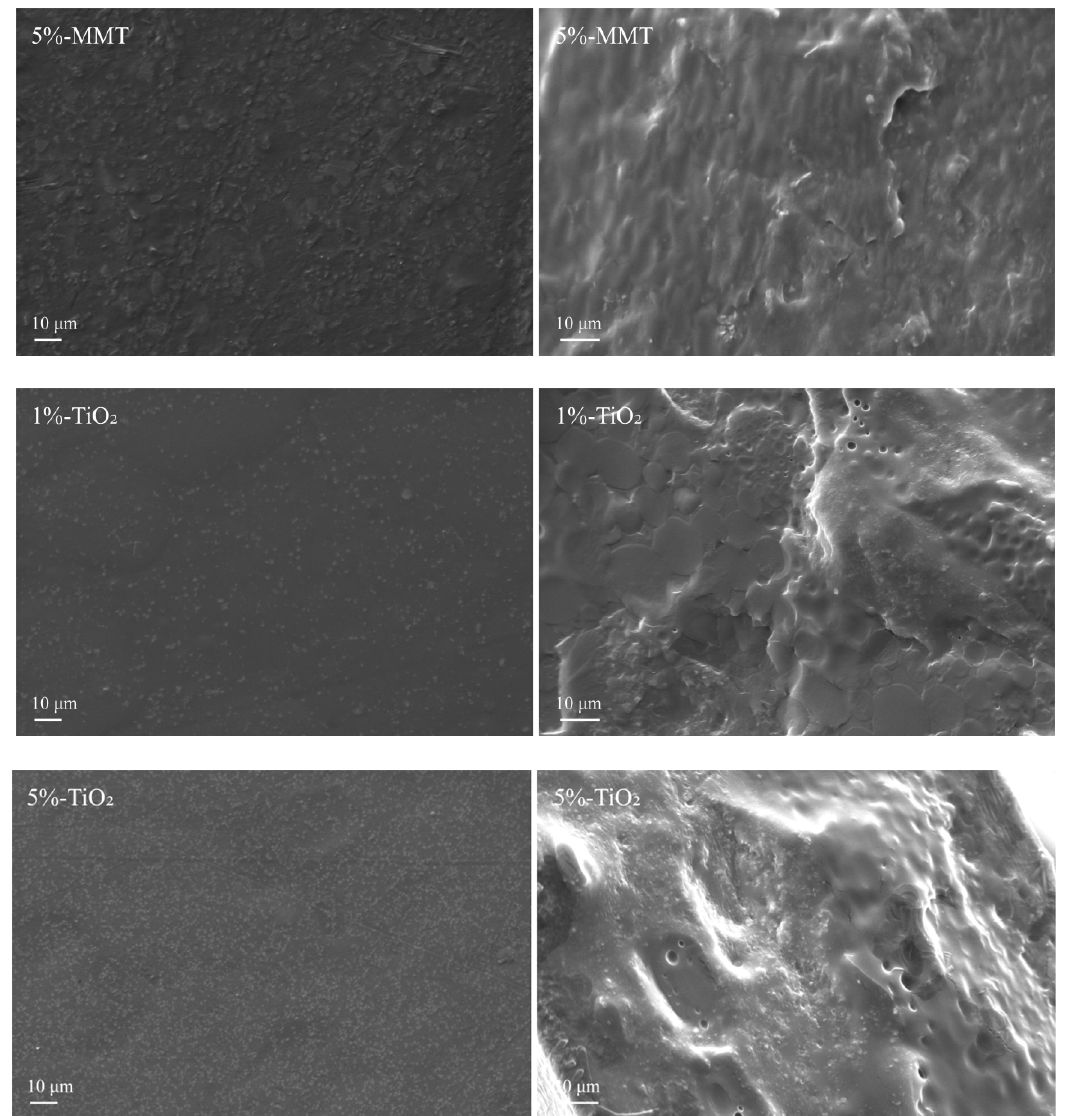
Figure 2. Representative SEM images of the surface morphology (left; 2000X) and the fracture morphology (right; 3000X) of the blend films.